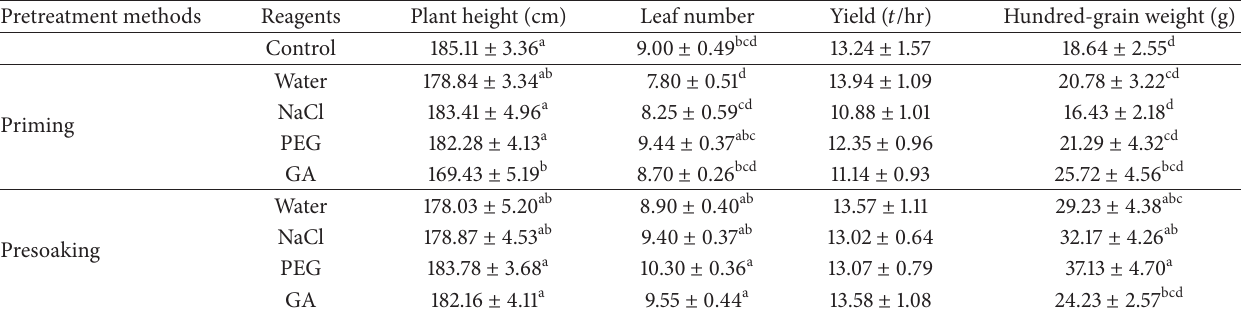
Table 2: Effects of pretreatment reagents and priming methods on yield composition of maize ( 𝑛 = 10